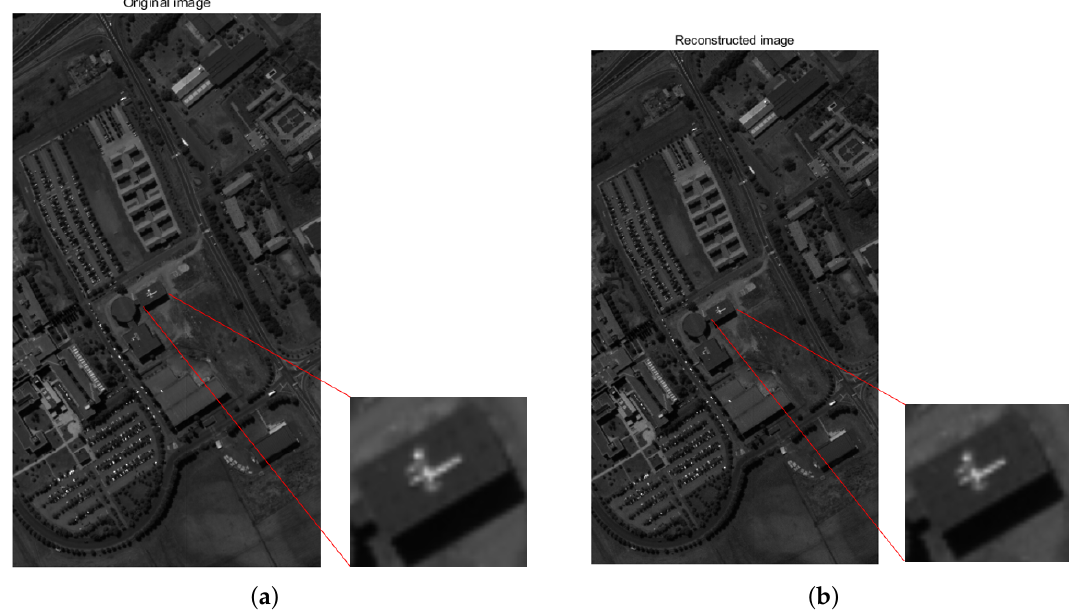
Figure 7. When the modulation function R calibrates the standard deviation σ to 1%, the algorithm is used to reconstruct the data cube PaviaU for restoration. The spectra of 52 channels were recovered using 98 broadband filters, and one of the single-wavelength images was taken to compare the recovery effect. ( a ) shows the original single-wavelength image, and ( b ) shows the recovered single-wavelength image. Local detail images are shown enlarged. (peak signal to noise ratio (PSNR): 40.1974; structural similarity (SSIM):